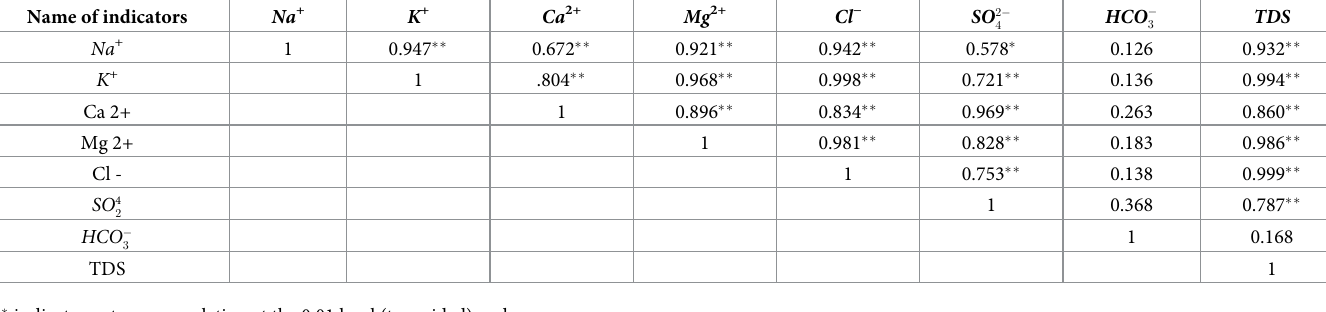
�� indicates a strong correlation at the 0.01 level (two-sided) and � indicates a strong correlation at the 0.05 level